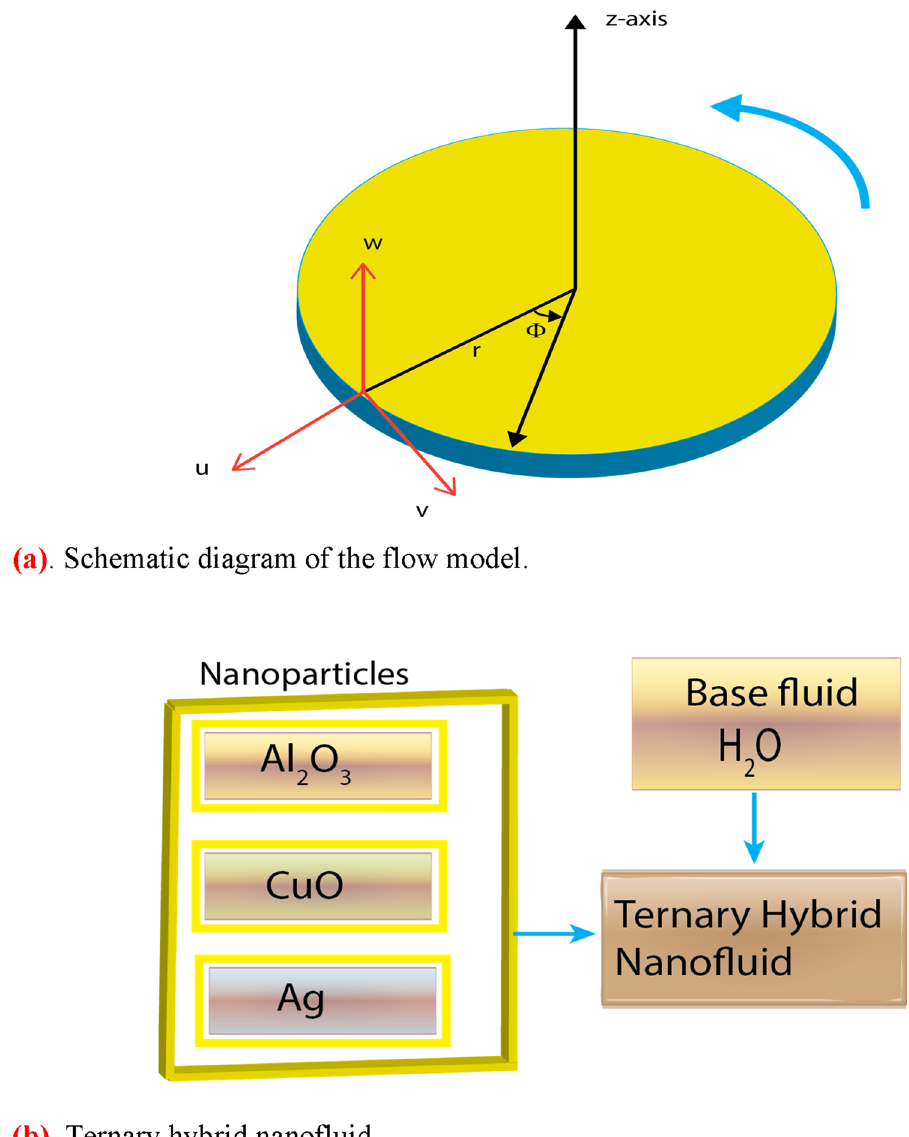
Figure 1. ( a ) Schematic diagram of the flow model. ( b ) Ternary hybrid